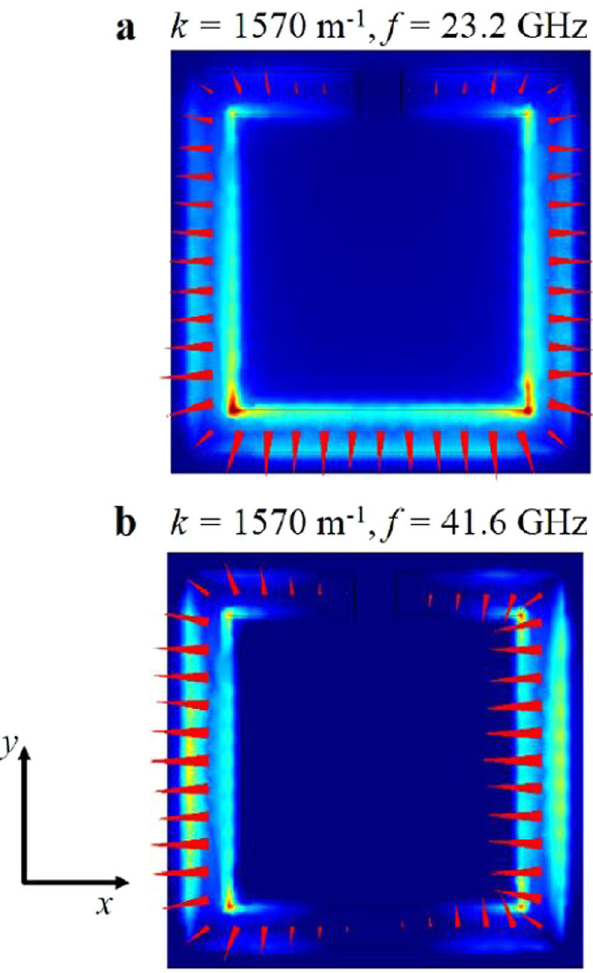
Figure 5. Simulated eigenmodes of the CSRR showing the electric field magnitude (background colour - red indicates high field and blue indicates low field) and direction (red vector arrows) plotted at the Brillouin Zone edge for ( a ) the lower and ( b ) the higher frequency